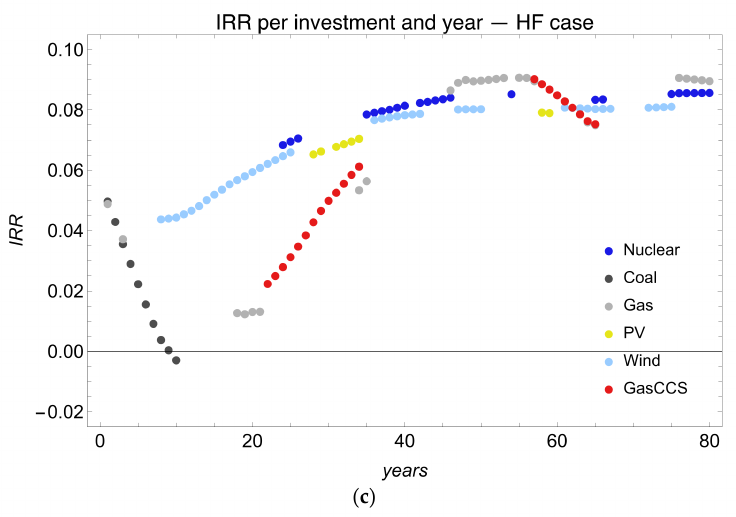
Figure 9. Internal rate of return (IRR) of investments in the ( a ) homogeneous case, ( b ) HHR case, and ( c ) HF case. Except for coal, the IRRs are mainly close to the level of the hurdle rates used by agents who make the